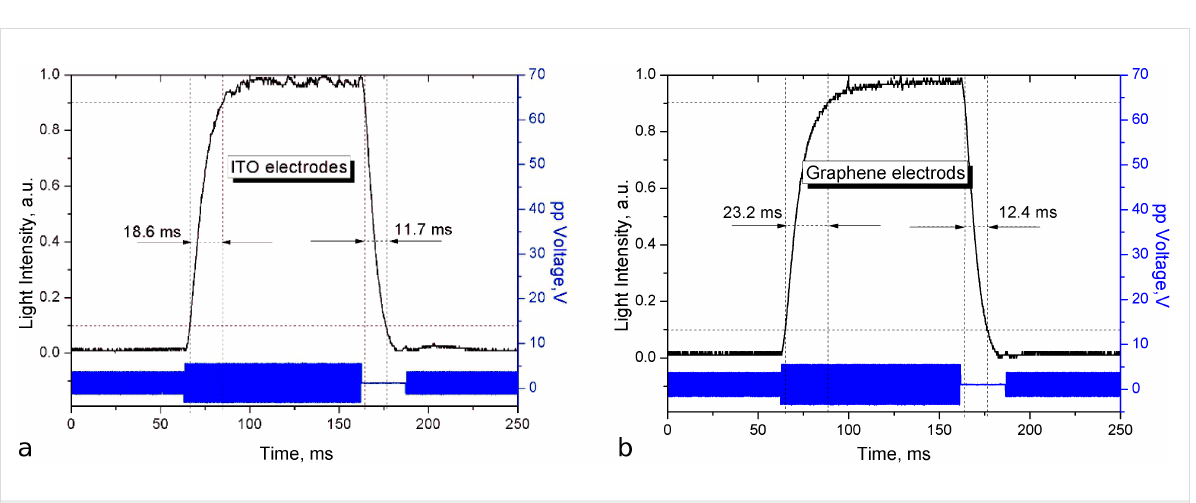
Figure 8: Time characteristic of liquid crystal cells with ITO (a) and graphene (b) transparent conductive layers operating as a light valve in the slow switching